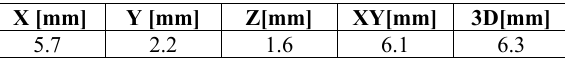
Table 1. Average camera location error.